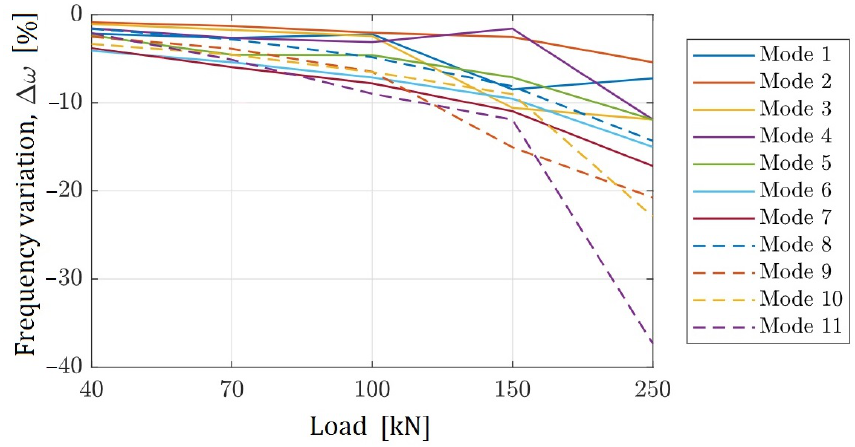
Figure 12. Change in natural frequencies.